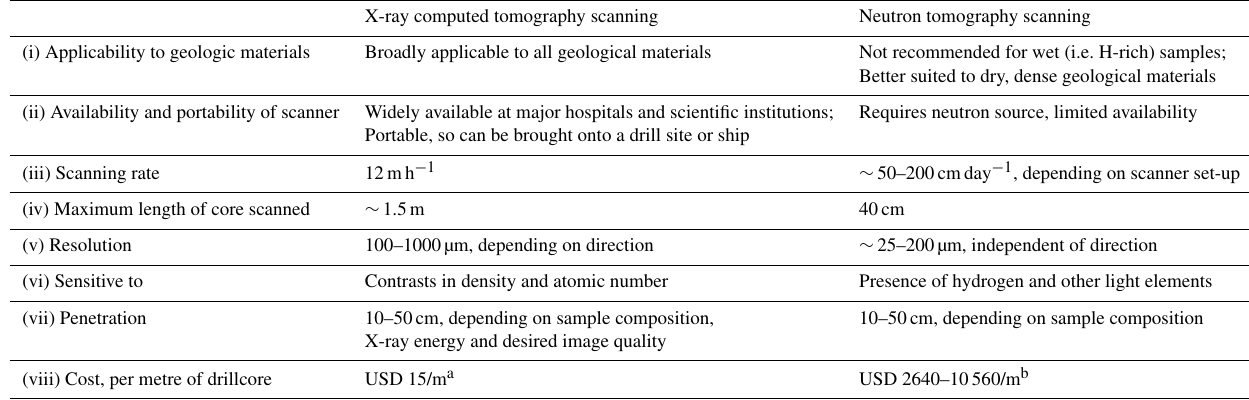
Table 2. A comparison of the practicality of CT and NT scanning in the framework of a drilling project. X-ray computed tomography